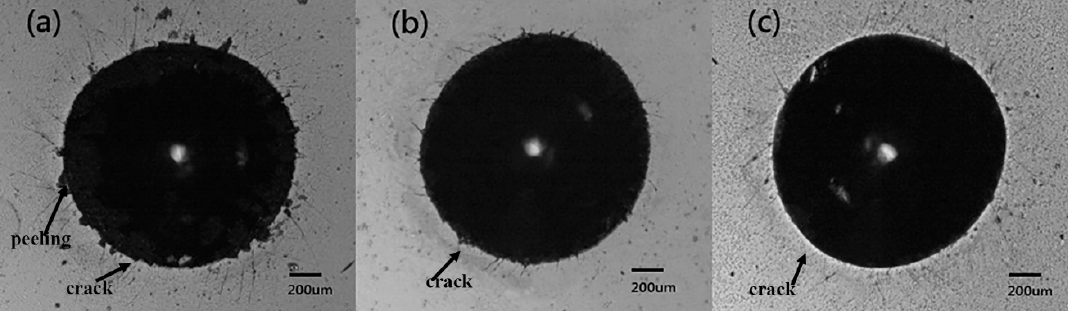
Figure 3. Rockwell morphologies of the coatings on coated HSS substrates ( a ) AlCrN coating, ( b ) AlCrVN coating, and ( c ) AlCrMoN coating. Table 2. Adhesion, coe ffi cient of friction, wear rate, hardness and elastic modules of the as-deposited coatings on HSS